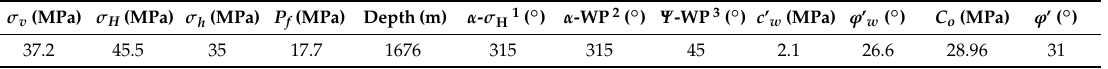
Table 4. Data used for the calculation of mud pressures at the Pedernales Field, Venezuela